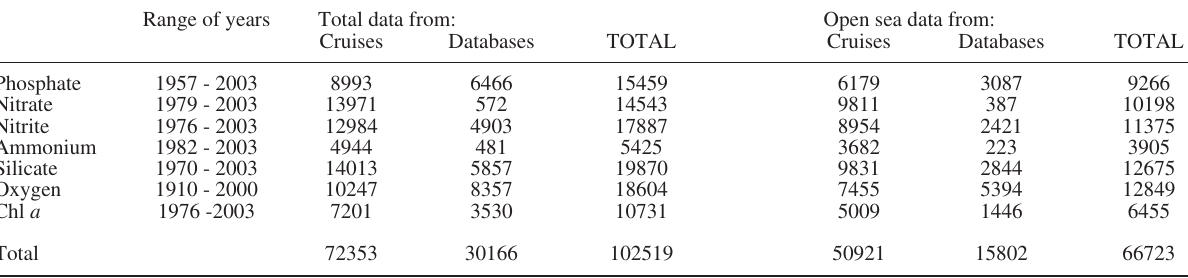
Table 1. – Total data and data from open sea stations for each oceanographic variable, obtained from the cruises gathered (“cruises” including “Meso 95”) and extracted from MEDATLAS and MATER Databases (“databases”). Open sea refers to stations with a bottom depth higher than 400 m. Range of years Total data from: Open sea data from: